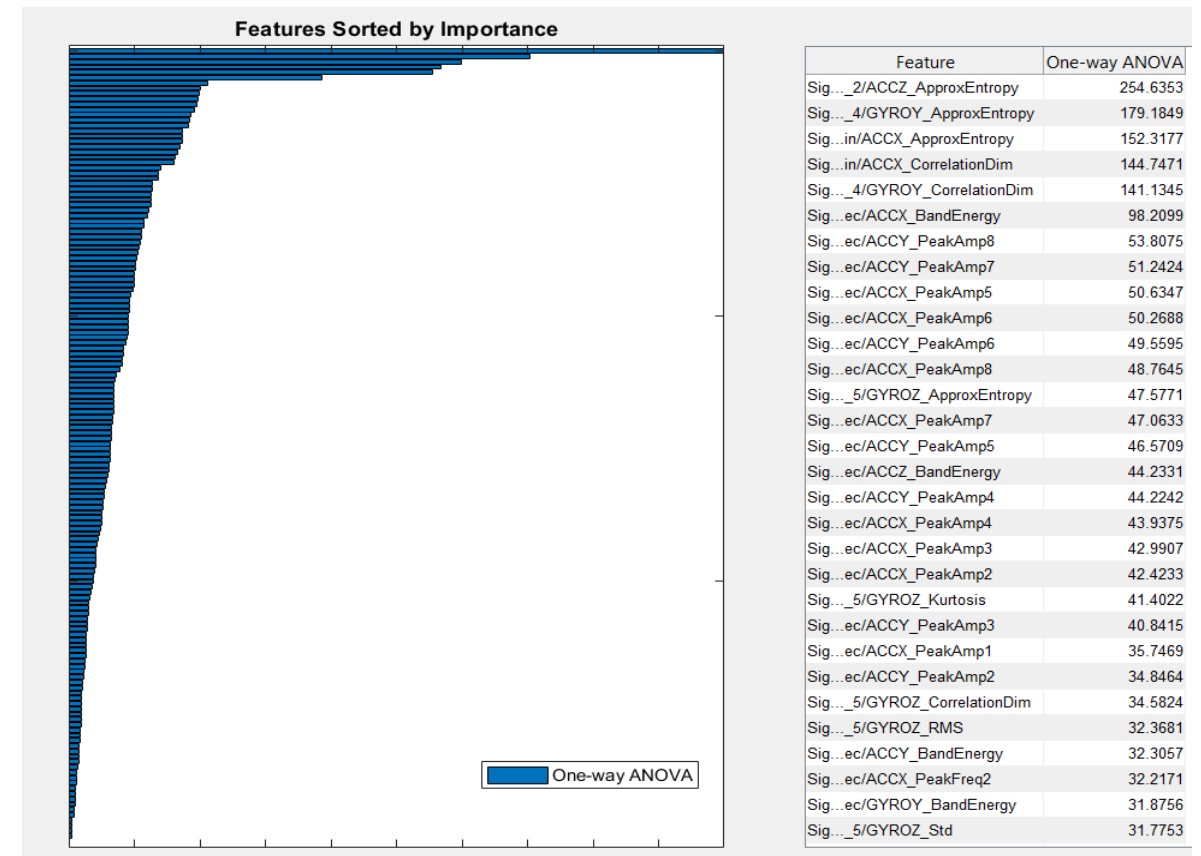
Figure 9. Features sorted by importance for the classifiers. The right side displays the ANOVA results, whereas the bars from the left side depict the normalized scores of different features.